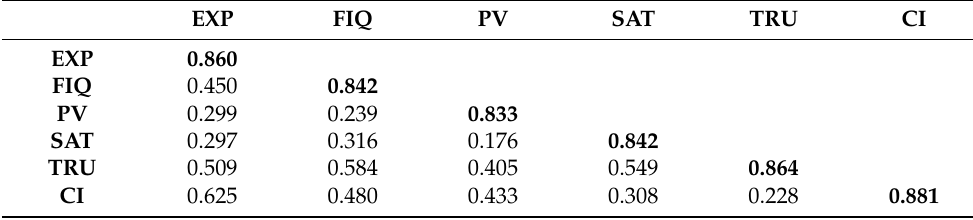
Table 5. Discriminant validity for the measurement model.